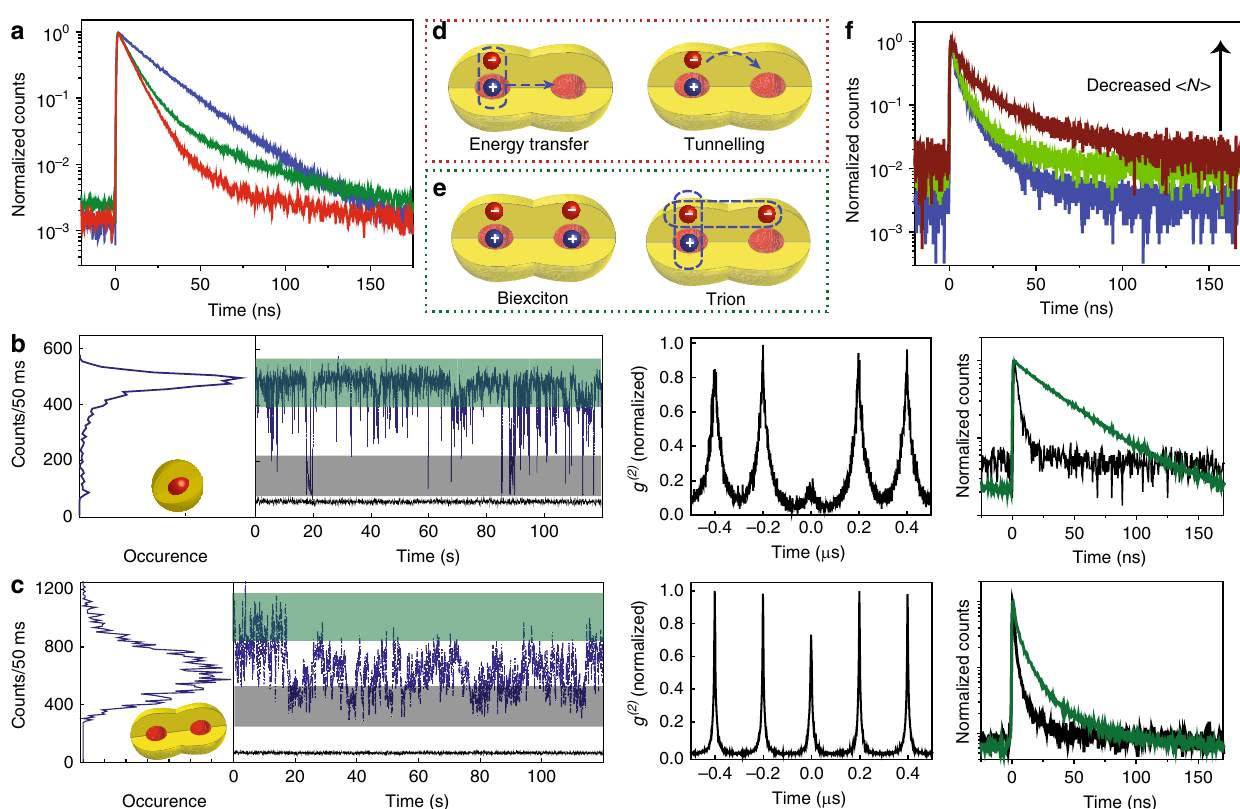
Fig. 5 Coupling effects through fl uorescence measurements for 1.4/2.1 nm CQDs molecules. a Ensemble photoluminescence lifetime decay for monomer (blue line), unfused dimer (green line), and fused dimer (red line). Time-tagged, time-resolved data for single ( b ) CQD monomer and ( c ) fused dimer. Shown are (from left to right) photoluminescence intensity time trace, second-order photon correlation and lifetime for the single particle respectively (the green and dark gray lifetime curves were generated from data shaded in the same color in the corresponding time traces). The excitation fl uence (< N >) for monomer and coupled dimer in the represented fi gures were 0.05 and 0.08, respectively. d Possible coupling mechanisms for shortening of lifetime in molecules. e Multicarrier con fi gurations. f Pump fl uence dependency of lifetime for an individual fused dimer. < N > values are 0.03 (brown trace), to 0.09 (green trace) and 0.18 (blue